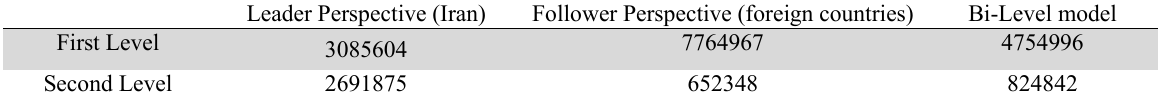
The objective functions from different points of view Leader Perspective (Iran) Follower Perspective (foreign countries) Bi-Level model First